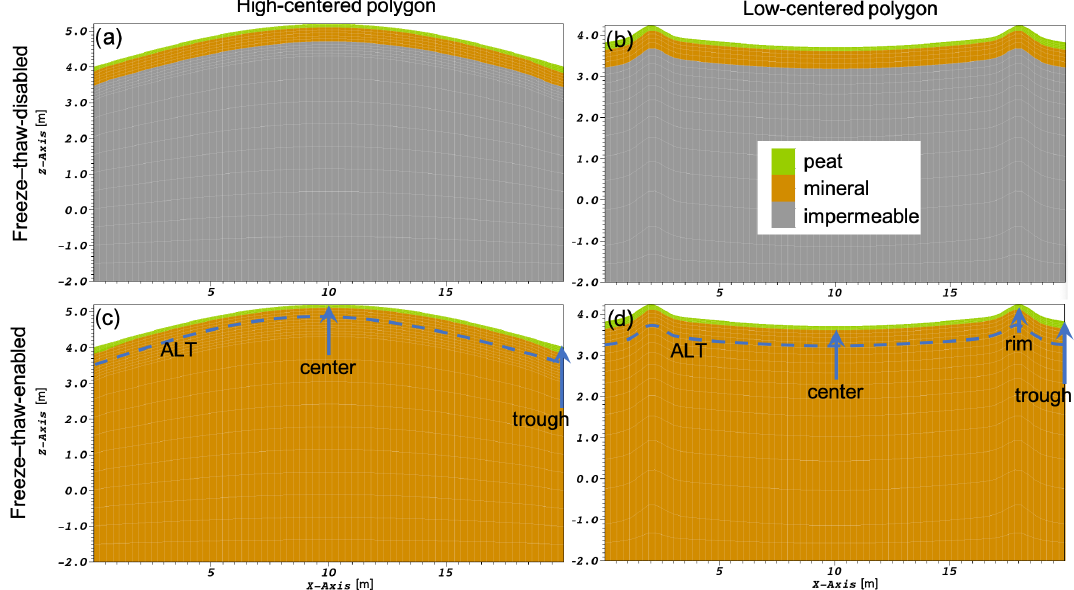
Figure 1. ATS meshes of 2D transects of a high-centered polygon (a, c) and a low-centered polygon (b, d) . The top row illustrates the stratigraphies representing the freeze–thaw-disabled case and the bottom row the freeze–thaw-enabled case. The green represents peat, brown the mineral soil layer, and grey the impermeable layer of the freeze–thaw-disabled case. Table 1. Subsurface thermal properties used for low- and high-centered polygons (from Jan et al., 2020).